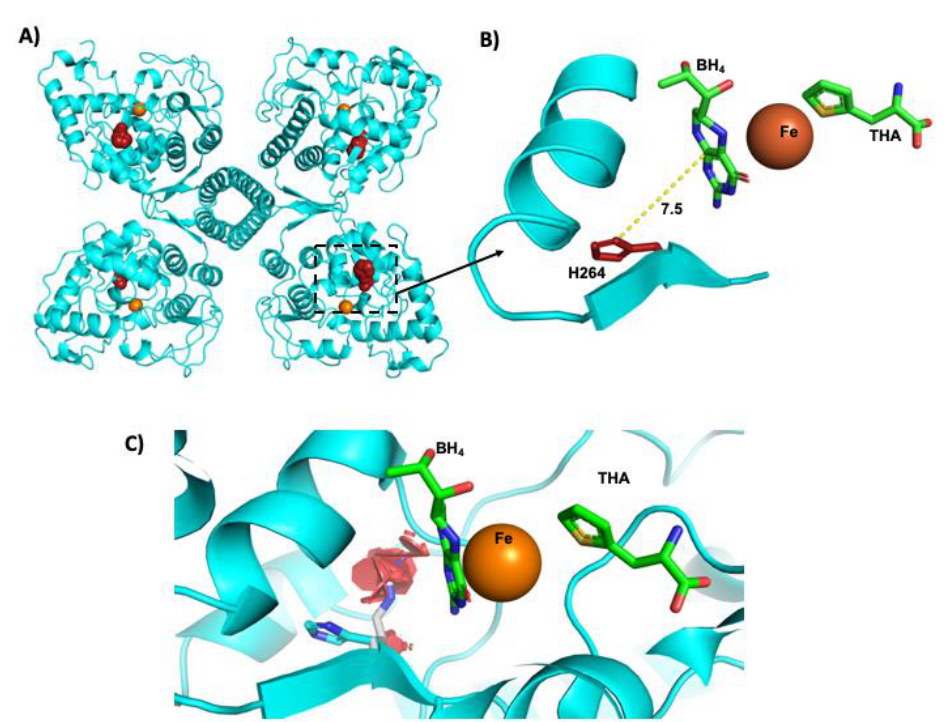
Figure 5. Location of His-264 residue in PAH structure. ( A ) His-264 residue is located within the vicinity of the active site; ( B ) zoom of His-264 location that shows a distance of 7.5 Å from the catalytic PAH site; ( C ) illustration of resulting repulsive clashes (red hexagons) conditioned by the His residue substitution by the positively charged Arg residue. The figure was constructed with Pymol